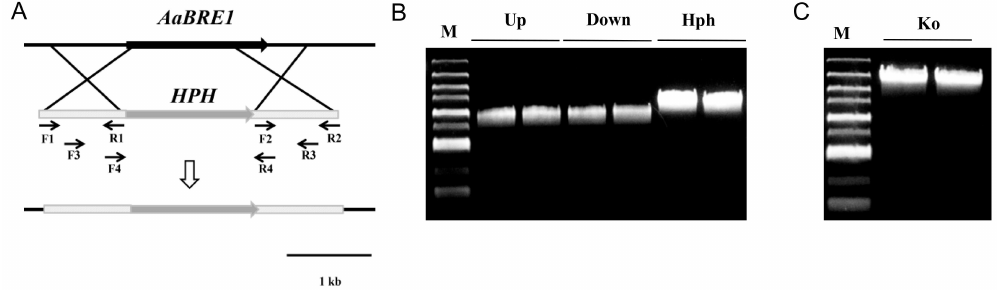
Figure 2. Schematic representation of the AaBRE1 deletion strategy. ( A ) AaBRE1 and hygromycin phosphotransferase fragment ( HPH ) are denoted by large black and grey arrows, respectively. Arrows indicate the annealing sites of PCR primers. ( B ) PCR products for the AaBRE1 gene replacement construct. DNA size marker (M); upstream of AaBRE1 gene replacement fragment (Up); downstream of AaBRE1 gene replacement fragment (Down); hygromycin phosphotransferase fragment (HPH). ( C ) PCR products for the full length of AaBRE1 gene replacement construct